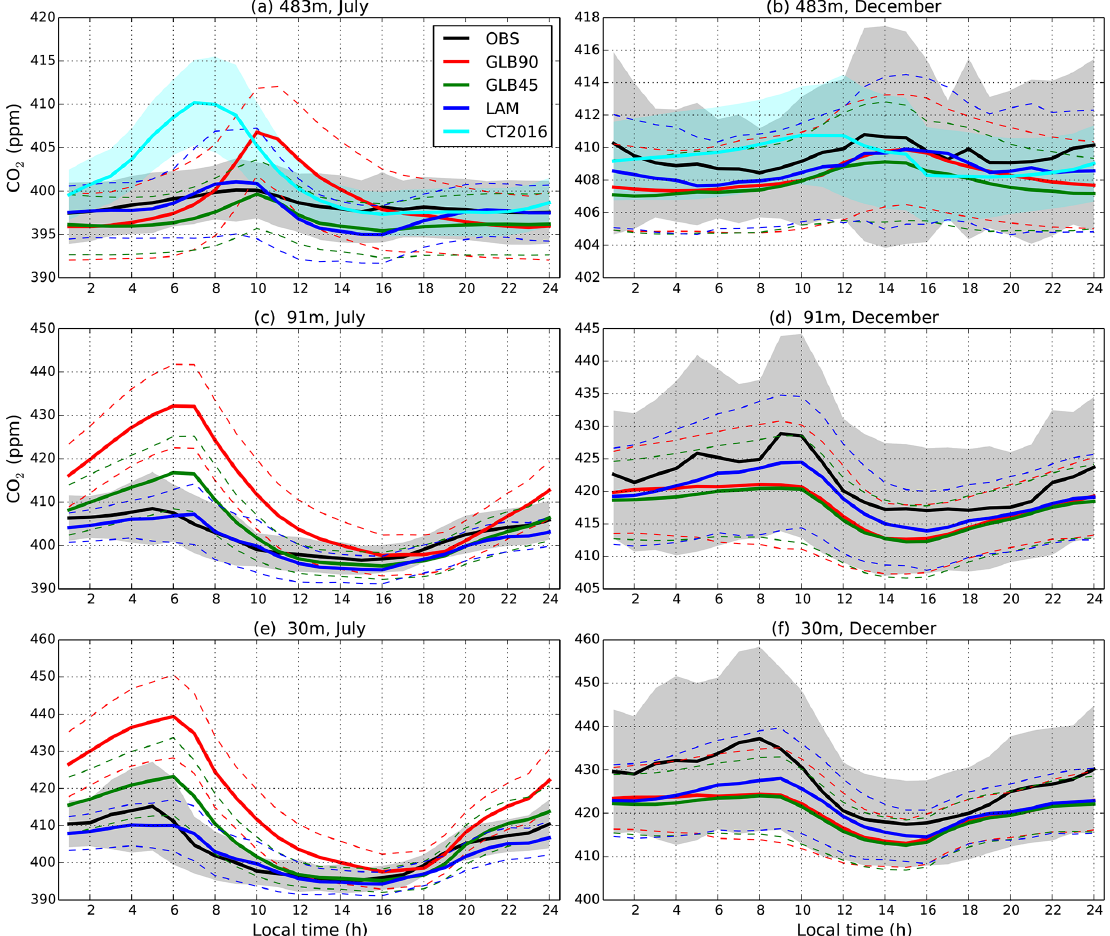
Figure 13. Mean diurnal cycle of observed CO 2 concentrations (black) and modelled CO 2 concentrations from the GLB90 (red), GLB45 (green) and LAM (blue) experiments at WGC (Walnut Grove, California) for intake heights of (a) 483m for July 2015, (b) 483m for December 2015, (c) 91m for July 2015, (d) 91m for December 2015, (e) 30m for July 2015 and (f) 30m for December 2015. The grey (cyan) shaded region indicates 1 standard deviation above and below observed (CT2016) CO 2 concentrations, while the dashed lines indicate the same for modelled CO 2 concentrations. Note that CT2016 results are only available at